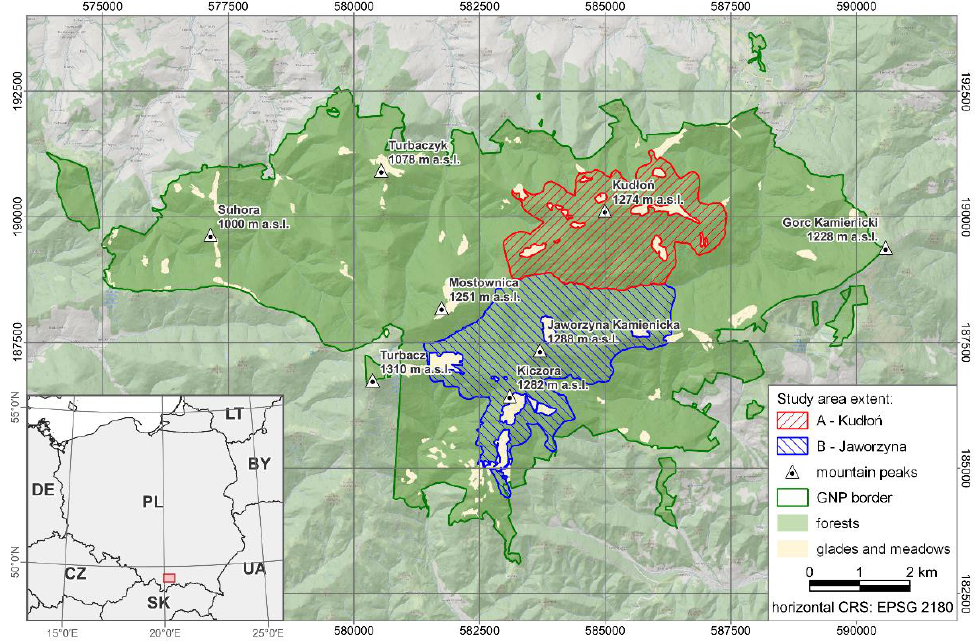
Figure 1. The location of the study area in Gorce National Park. Subarea A (the Kudłoń range) in the northern part and subarea B (the Jaworzyna Kamienicka range) in the southern part. The test area (Figure 1) covered 1616.43 ha and was located in the Kudłoń and Jaworzyna Kamienicka ranges, including the valley of Kamienica stream between them.